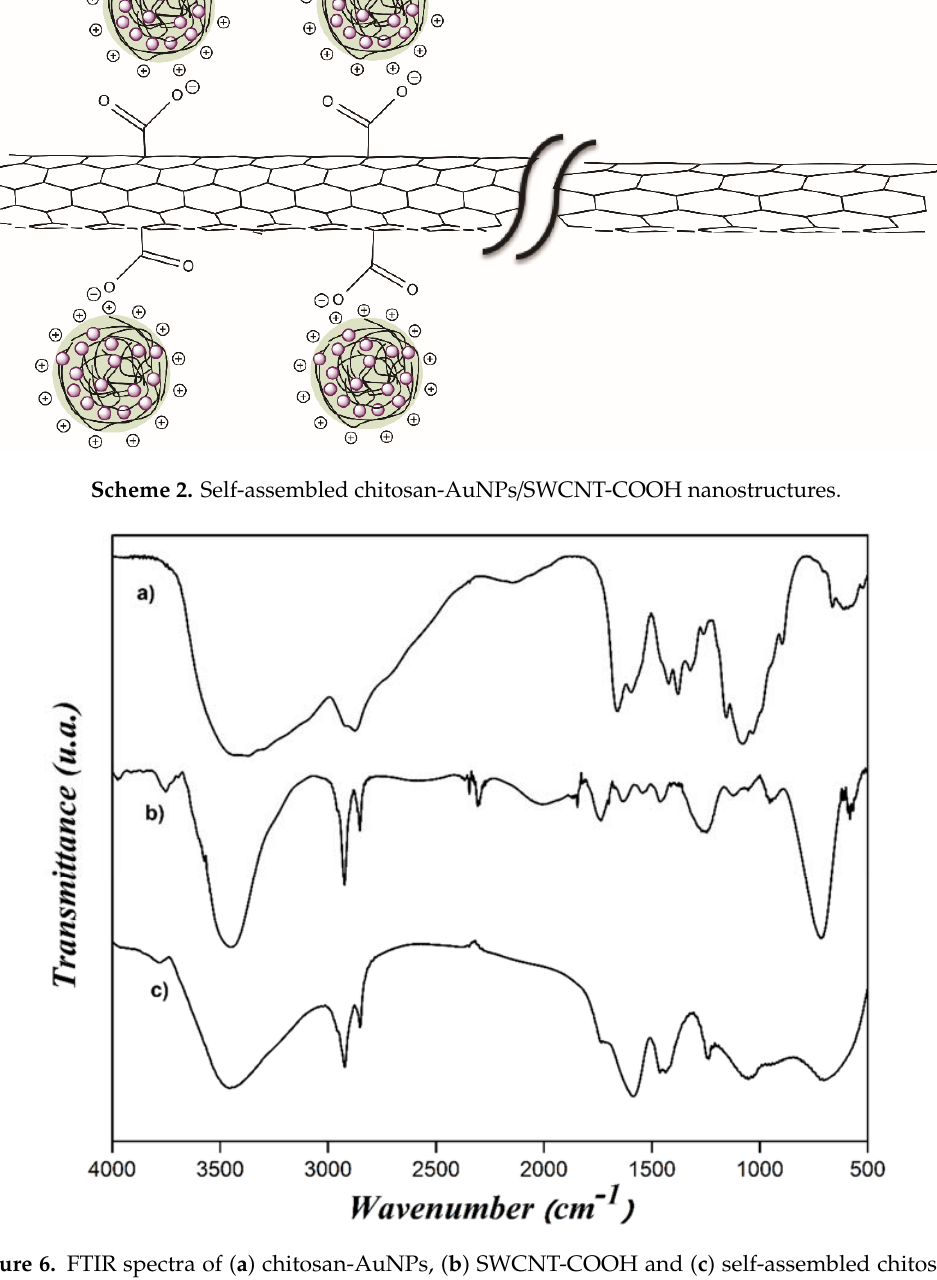
Figure 6. FTIR spectra of ( a ) chitosan-AuNPs, ( b ) SWCNT-COOH and ( c ) self-assembled chitosan-AuNPs / SWCNT-COOH nanostructures.